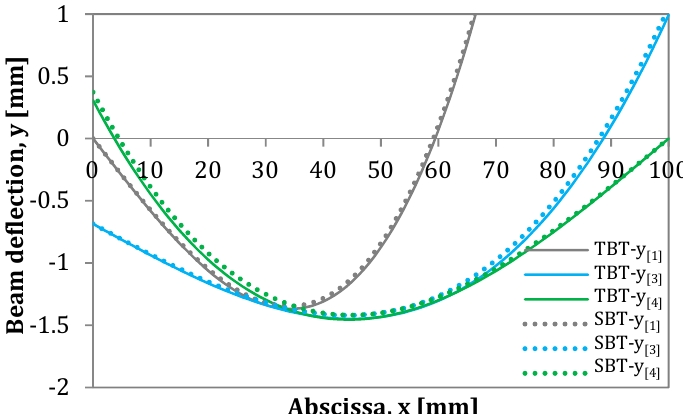
Figure 5. Deflection curves for the four regions of the loaded AENF specimen.